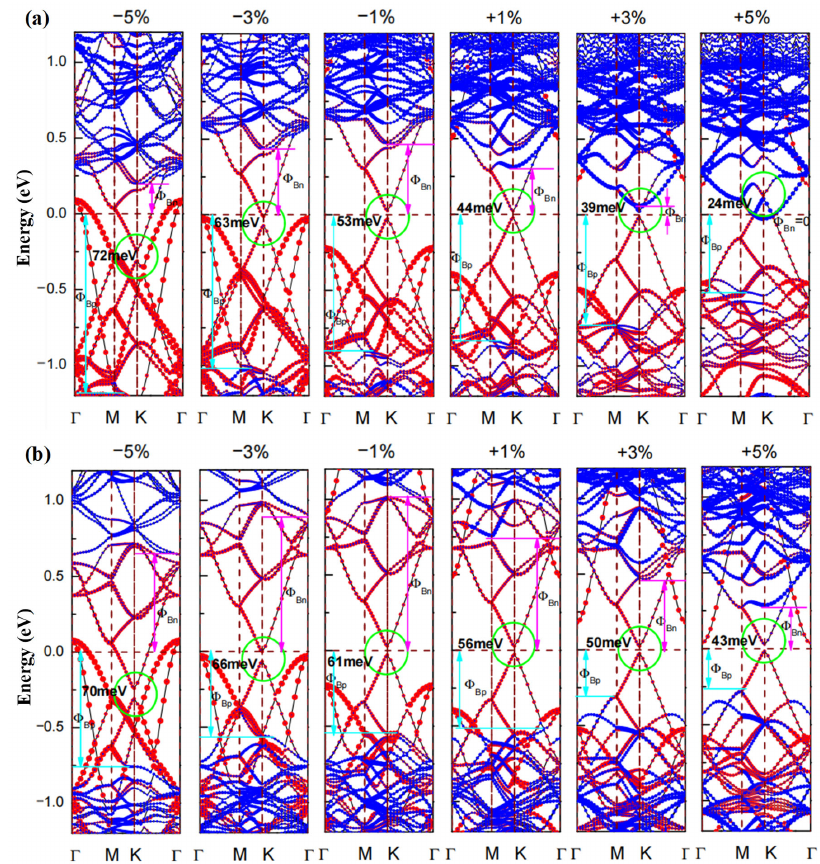
Figure 6. The weighted electronic band structures of ( a ) Ge/SMoSe and ( b ) Ge/SeMoS under different deformation strains, the contributions of MoSSe and germanene are marked by solid blue and red circles, respectively. The Dirac gap is marked with green circle, the n ‐ type and p ‐ type Schottky barrier heights ( Bn and Bp ) are marked with magenta and cyan arrowlines, respectively.